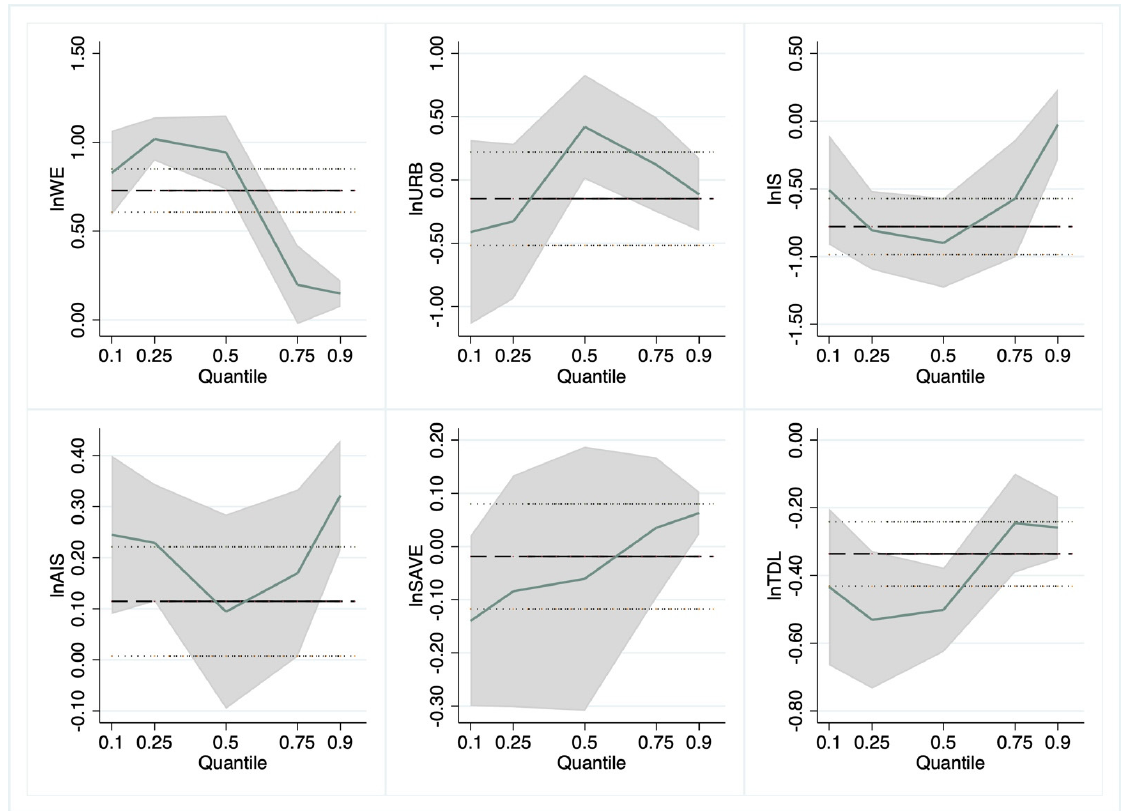
Figure 4. Change in panel quantile regression coefficients. Notes: the x -axis represents the conditional quantiles of ACE and y -axis denotes the coefficient values of various variables. The black line indicates the coefficient values of panel data model with fixed effect. Table 5. Estimation of two-step panel quantile regression. Table 6. Results of the region’s heterogeneous